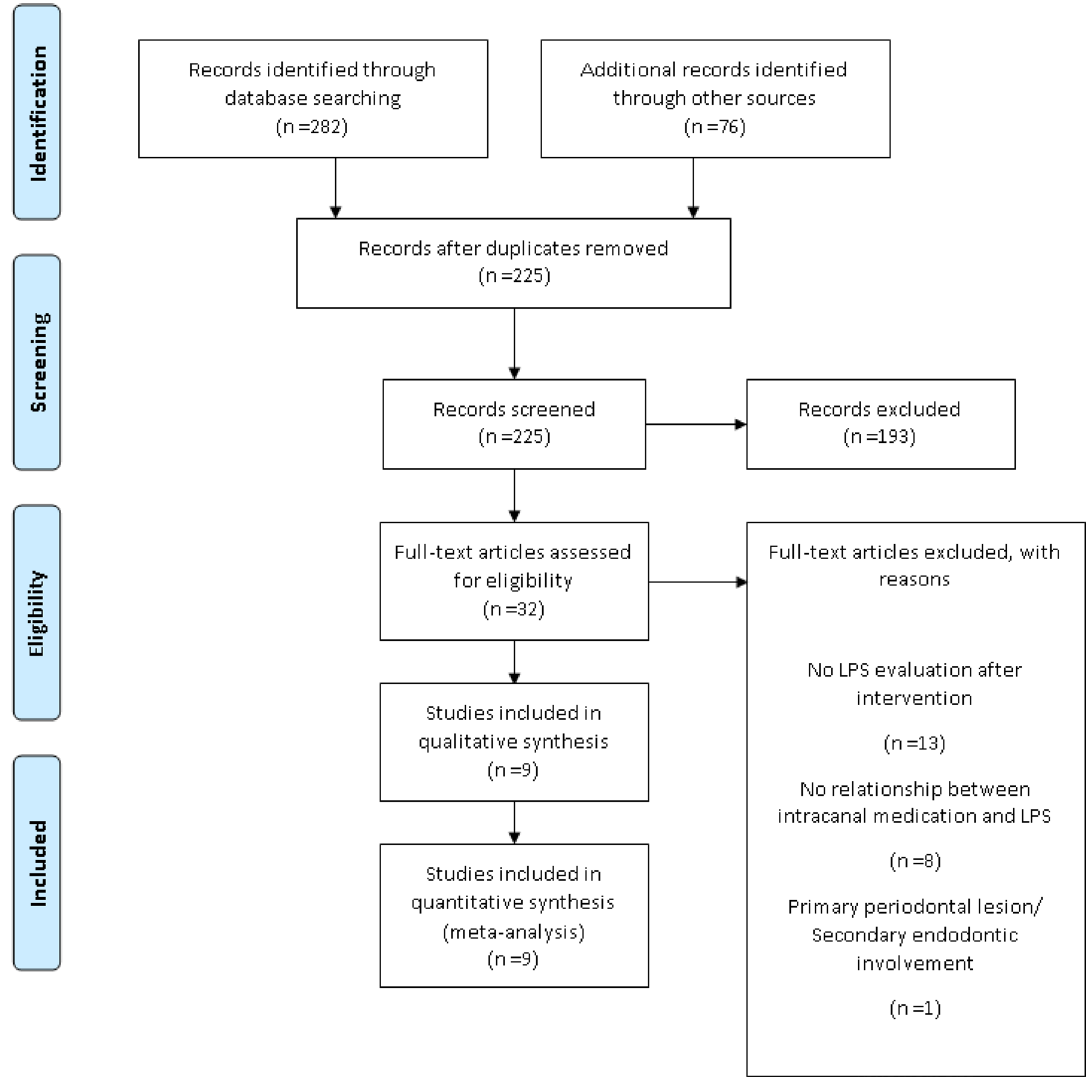
Figure 1. PRISMA flowchart of the study selection